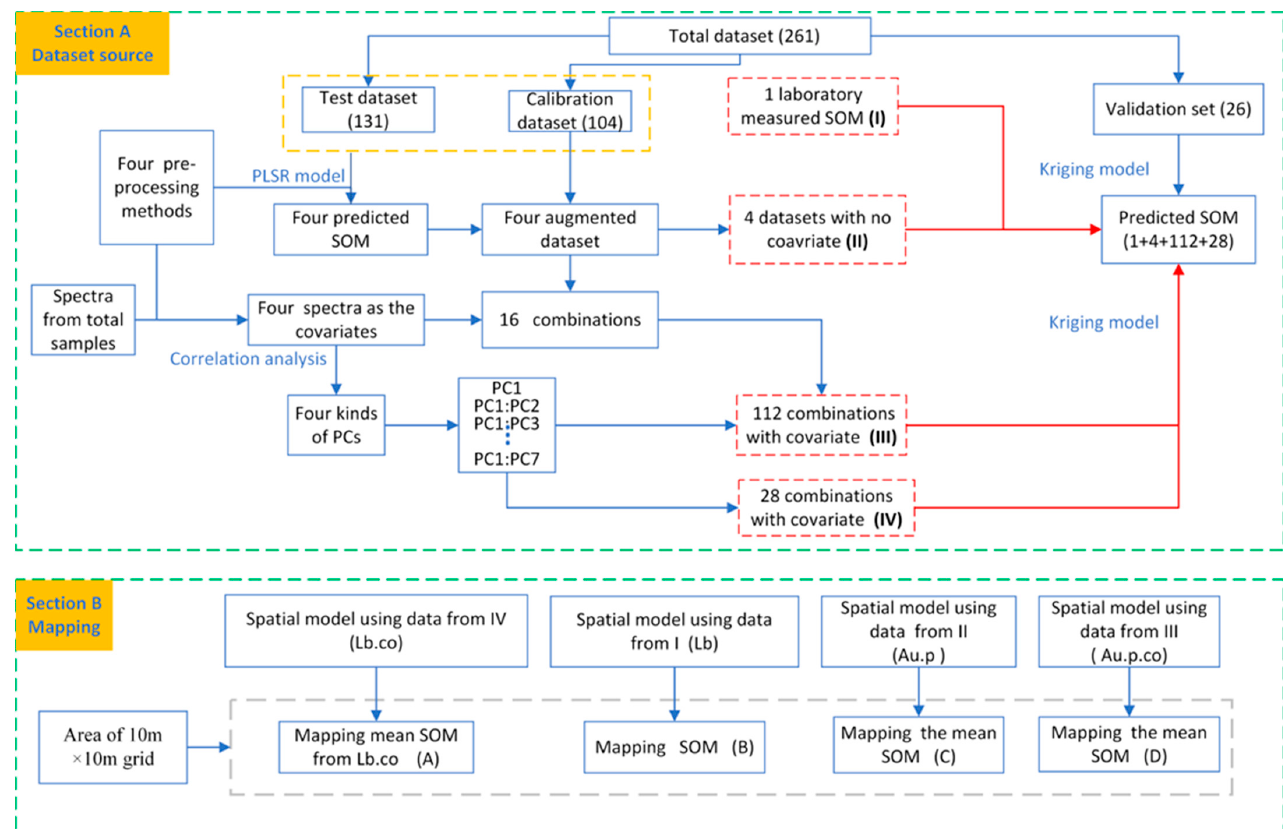
Figure 2. Dataset from the combination and the mapping flowchart. The letters (A)–(D) correspond with data of the laboratory ‐ based (Lb), vis ‐ NIR augmented datasets (Au.p), the laboratory ‐ based with pcs covariate (Ld.co), vis ‐ NIR augmented datasets with pcs covariate (Au.p.co).